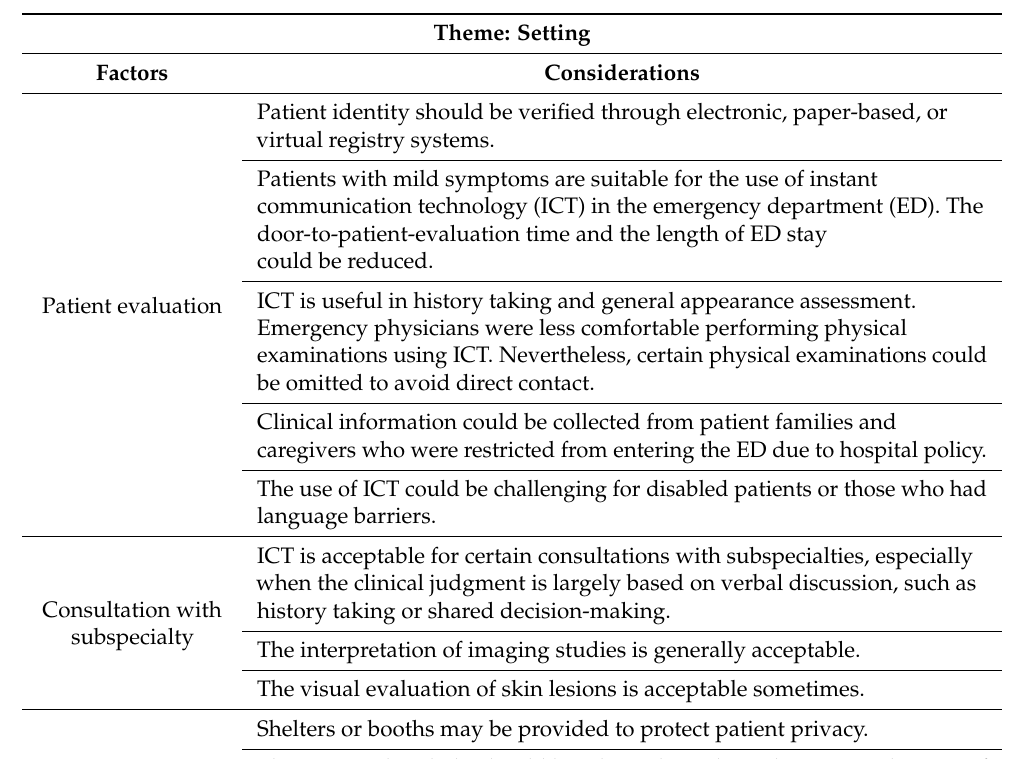
Table 1. Important considerations regarding the setting when using instant communication technol- ogy for patient assessment in an emergency